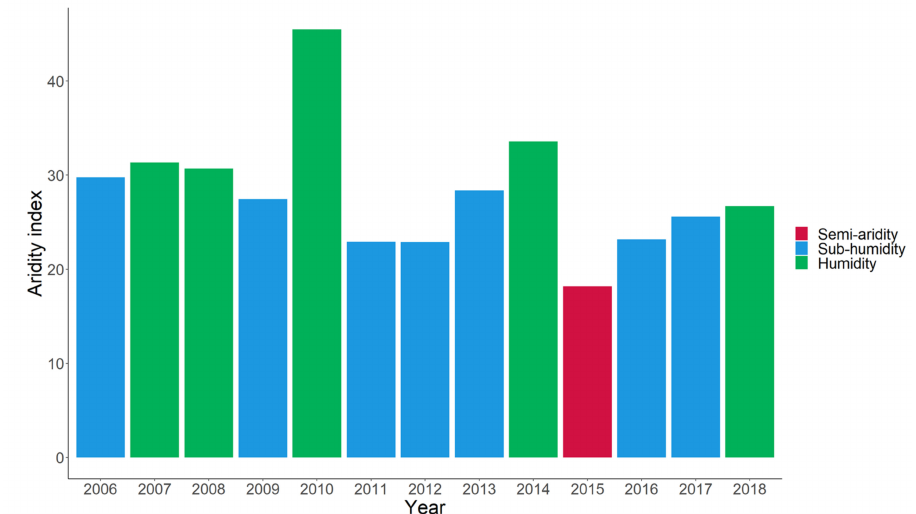
Figure 1. Thermo-pluviometric regimes of the study-site according to the De Martonne-Gottmann aridity (yearly